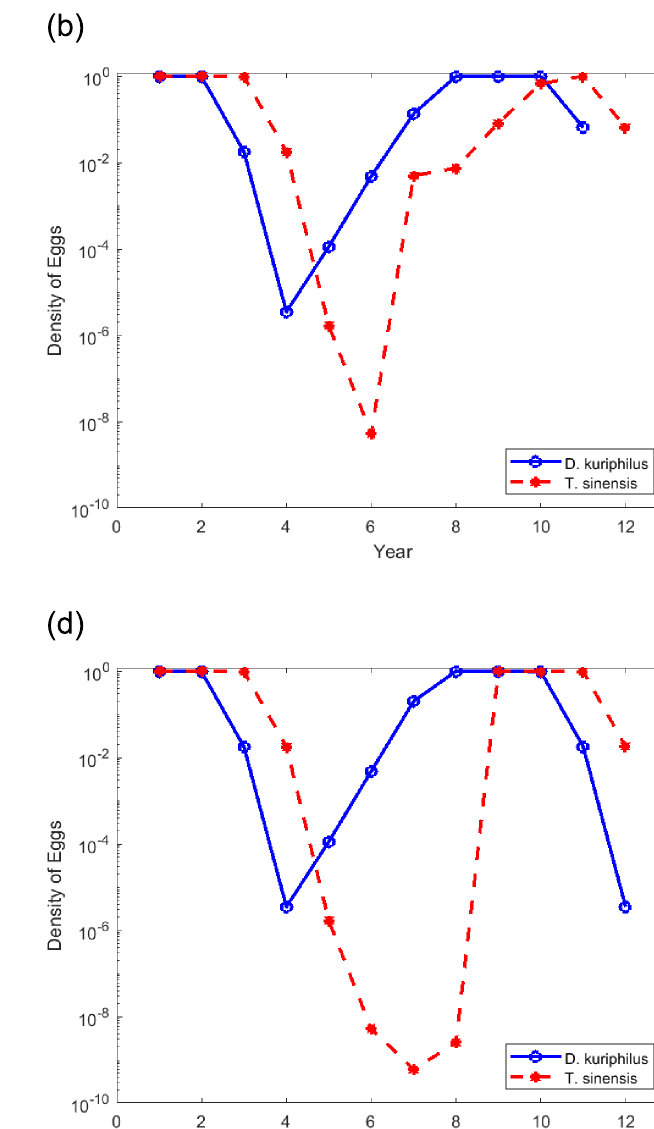
) and T. sinensis ( q ) in a given place of the forest over the time after several releases of T. sinensis made simultaneously, at n n